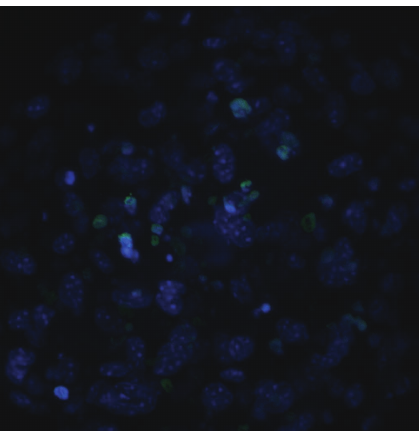
Figure4:Confocalmicroscopyimageofthemiddlesection(center) of a 30,000 cells’ spheroid obtained from MC3T3-E1cells, stained for caspases 3/7, indicating apoptosis